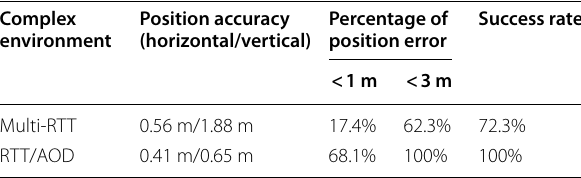
Table 2 Statistical results of Multi-RTT and RTT/AOD positioning errors in a complex environment Complex environment